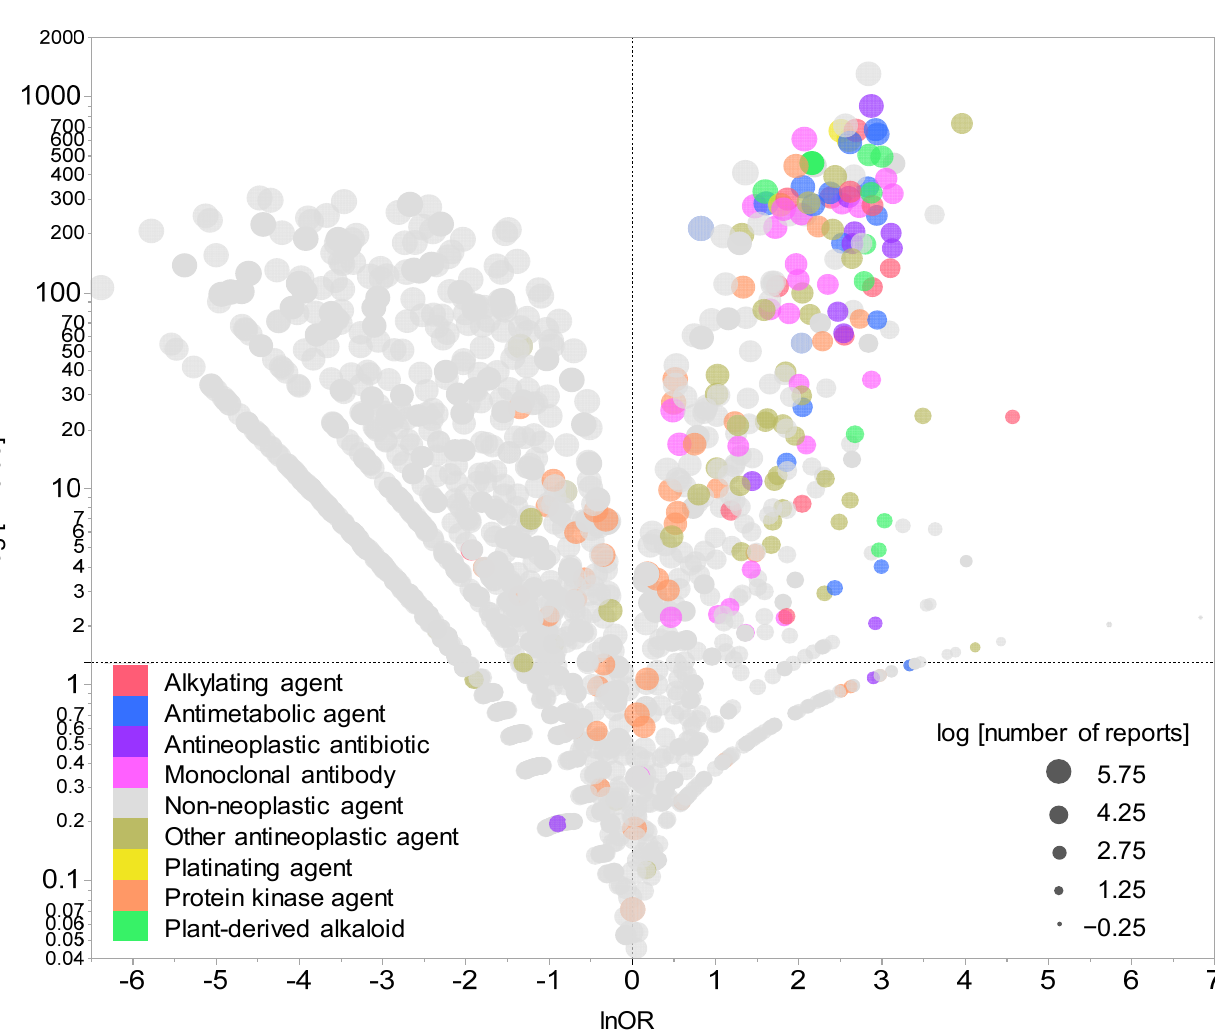
Figure 2. Drugs associated with CIN development. The X axis shows the natural lnORs, whereas the Y axis shows the common logarithm of the inverse p value ( − log10( p value)) from Fisher’s exact test. The ORs were calculated using cross- tabulation. The dotted line on the Y axis represents p = 0.05. The plot colors indicate Anatomical Therapeutic Chemistry classification, whereas the plot size indicates the common logarithm of the total number of reported adverse events for each drug ( − 0.25 to 5.75).